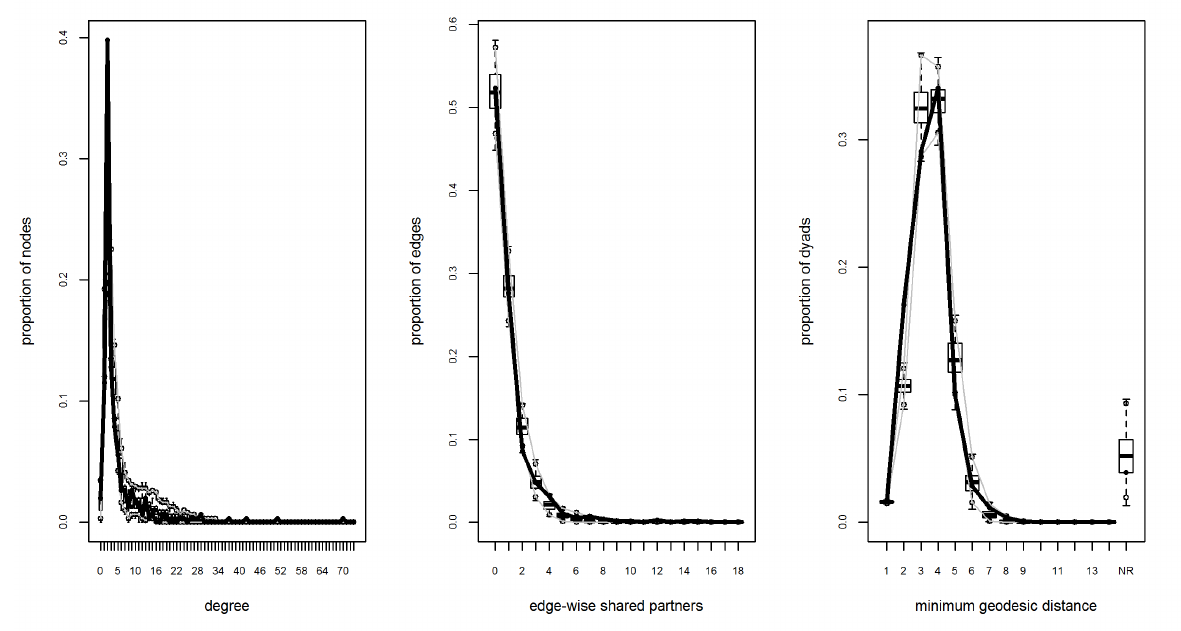
Figure A3.2: GOF plots for the regional-level ERGM